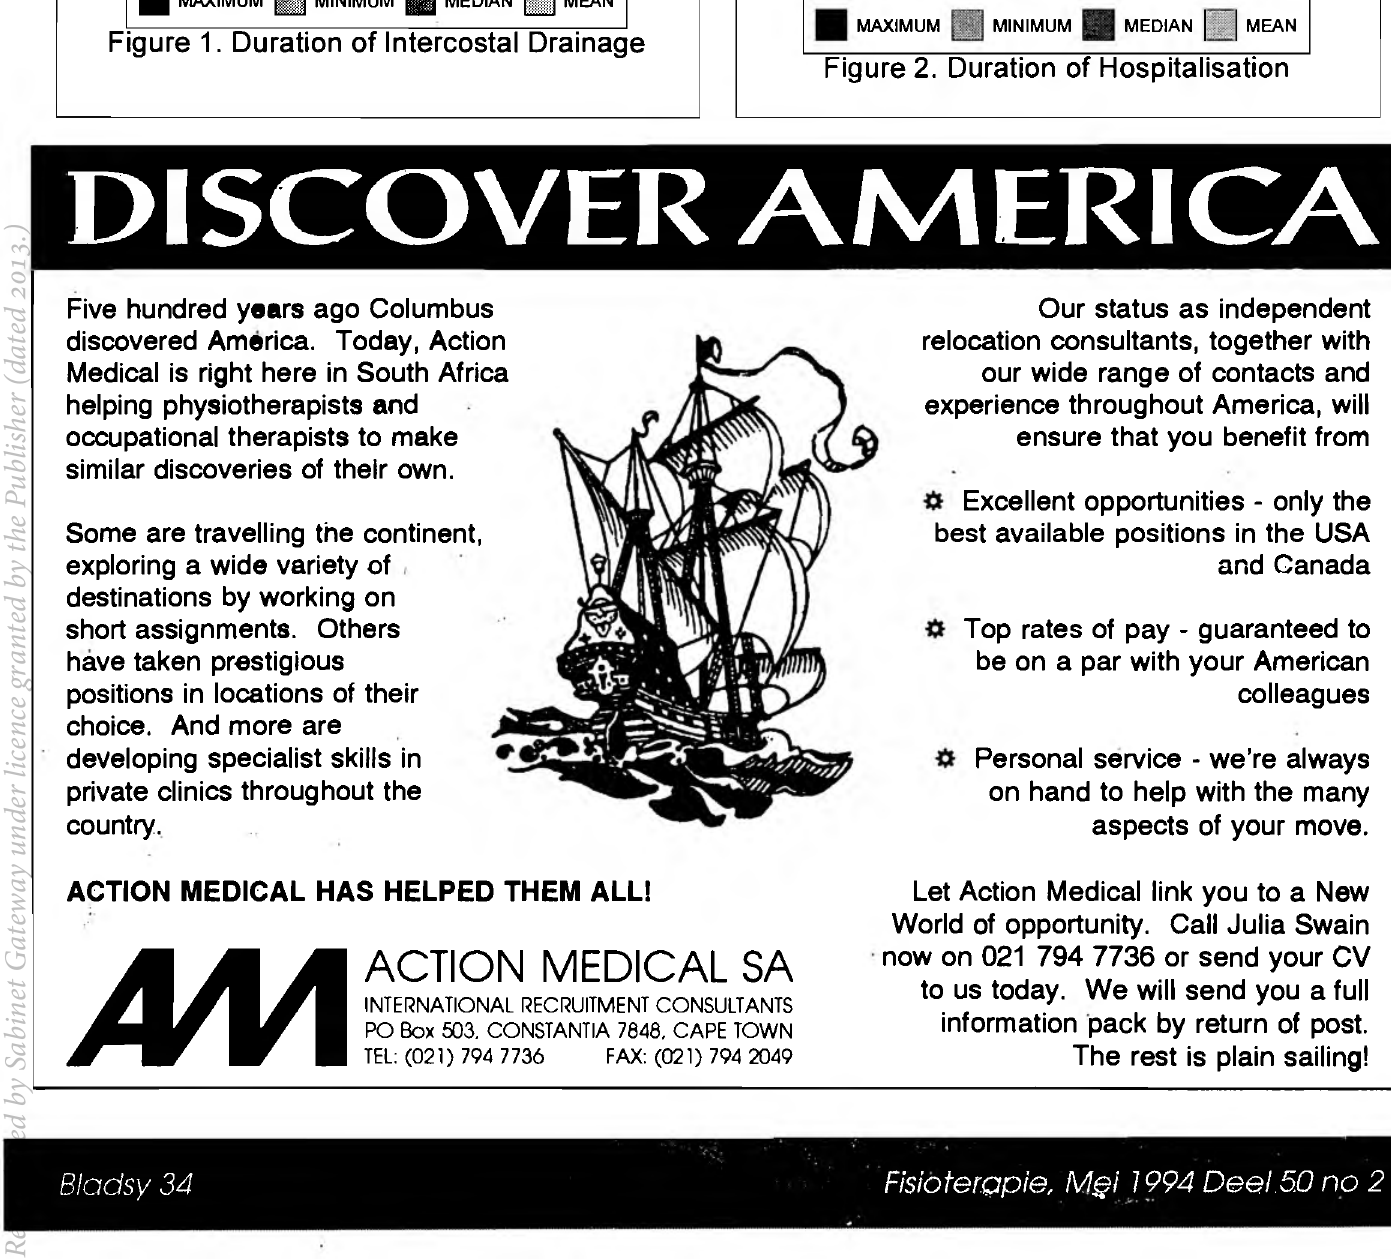
Figure 2. Duration of